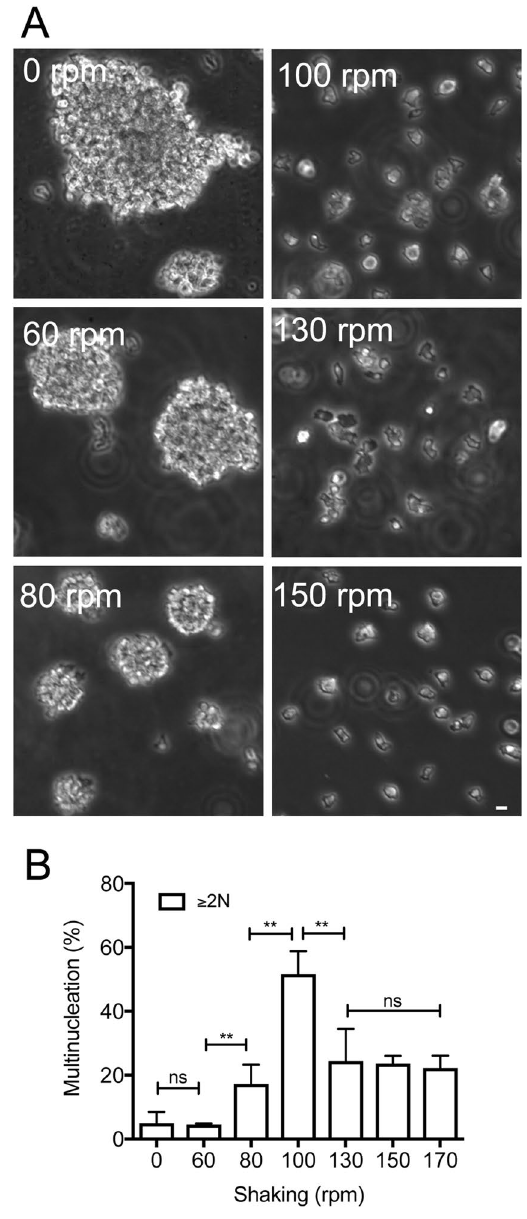
Figure 6. Shearing force is required for cell division in shaking culture. ( A ) Phase-contrast microscopy images of wild-type cells cultured for 24 h in shaking culture at 60, 80, 100, 130, and 150 rpm. As a control, the cells were cultured in a Lipidure-coated dish without shaking (0 rpm). Note that large multicellular aggregates formed at speeds lower than 80 rpm. ( B ) Frequency of multinucleation of the cells cultured at different shaking speeds. The cells were stained with DAPI (more than 500 cells were counted for each shaking condition in three independent experiments). At lower speed ( < 60 rpm), the cells formed multicellular aggregates, and most of cells remained mononucleated. At moderate speed (100 rpm), most of the cells were separated and became multinucleated (51.3 ± 7.2%, n = 1,500). At the standard speed (150 rpm) and higher, all of the cells were separated and showed less multinucleation (~20%). Data are presented as mean ± SD. ** P ≤ 0.001; ns, not significant, P > 0.05. Bar, 10 µ